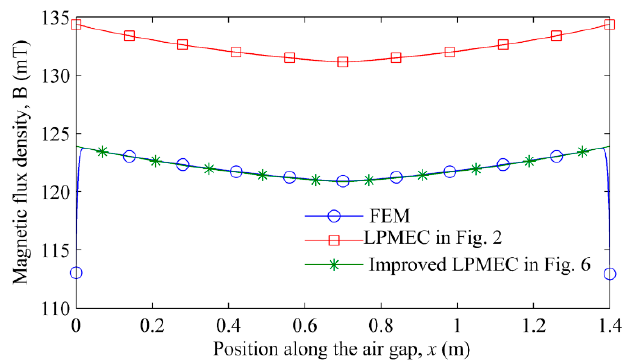
Figure 9. Magnetic flux density (MFD) distributions given by finite element method (FEM) and theoretical models.